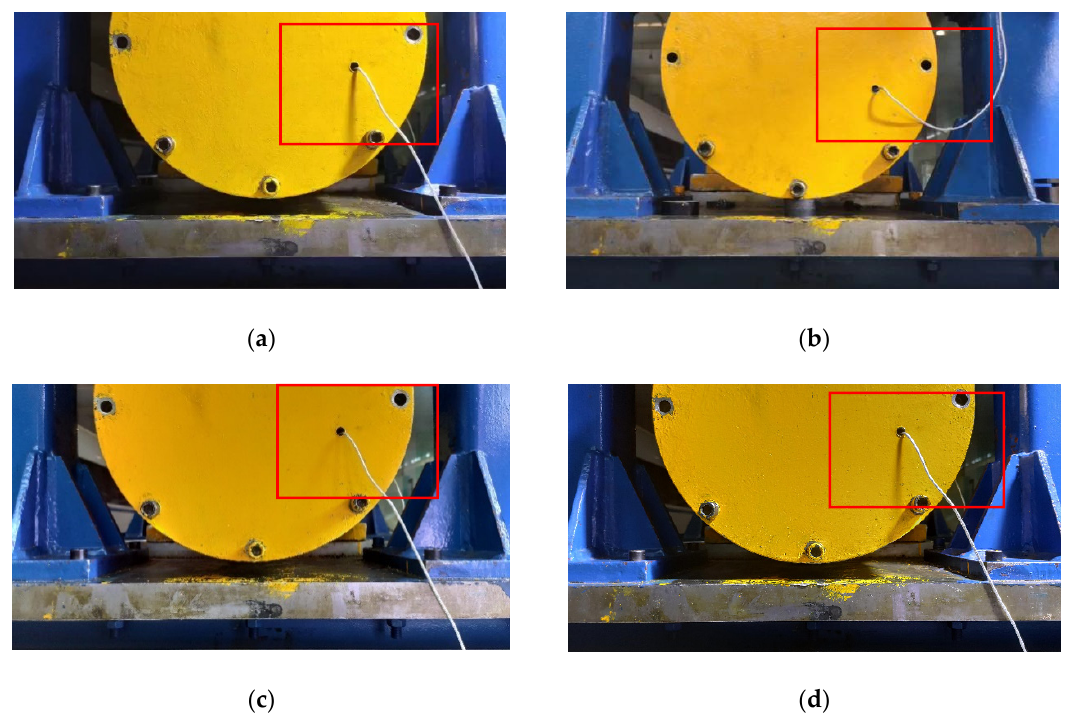
Figure 9. Images of the platform in different ray directions: ( a ) image under strong supplementary light source condition; ( b ) image under strong natural light conditions; ( c ) Images under low natural light conditions; ( d ) image under weak supplementary light source